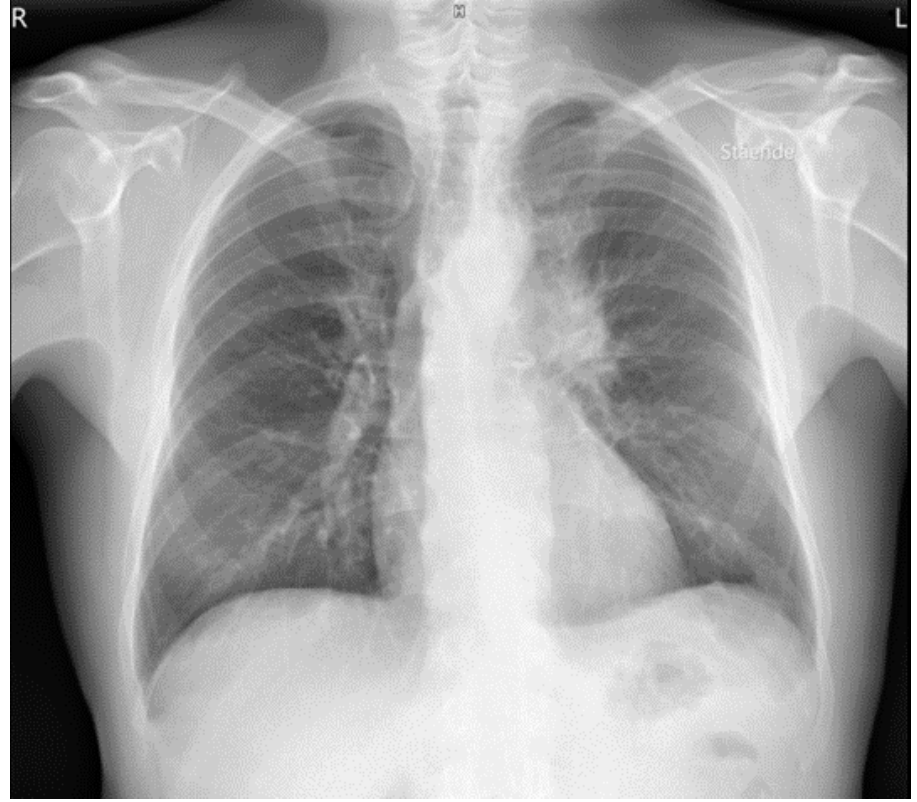
Figure 1. Chest X-ray with a large left hilar mass.